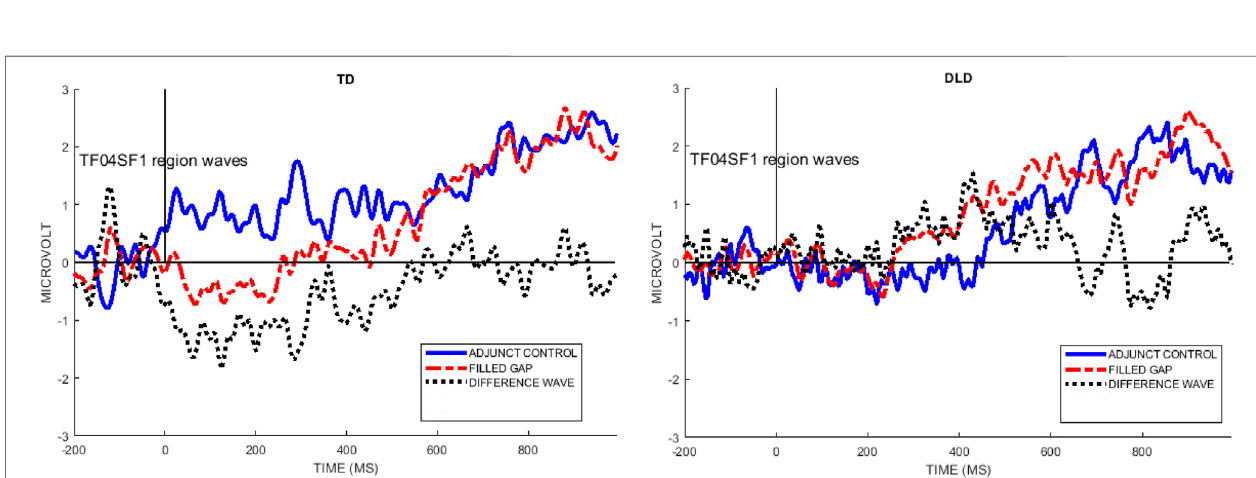
FIGURE8| Timesamplesandelectrodesexceeding0.6factorloadingsselectedfromtheEAN(TF04SF1)component,forderivingavoltagemeasurefromthistime window and electrode region.